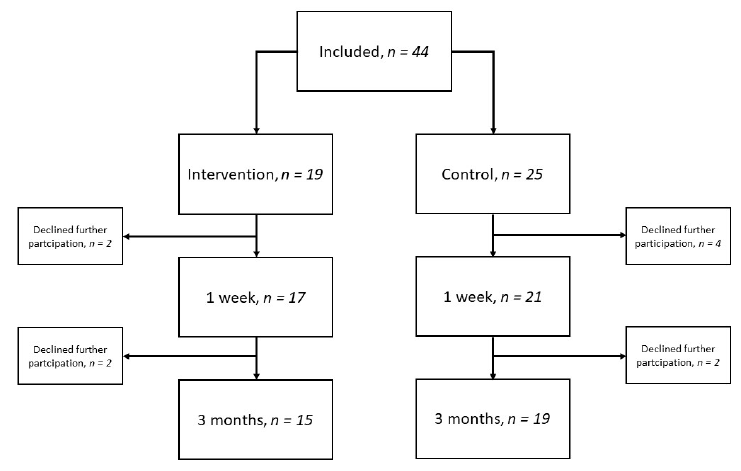
Figure 1. Flow diagram over included participants and time-point for follow-up. The demographic and clinical characteristics of the participants are presented in Ta- ble 1. The baseline characteristics of the intervention and control groups were comparable except for the level of education, as 60% in the intervention group had a university degree in comparison to 29% in the control group ( p = 0.049). Table 1. Demographics and clinical characteristics of the participants.